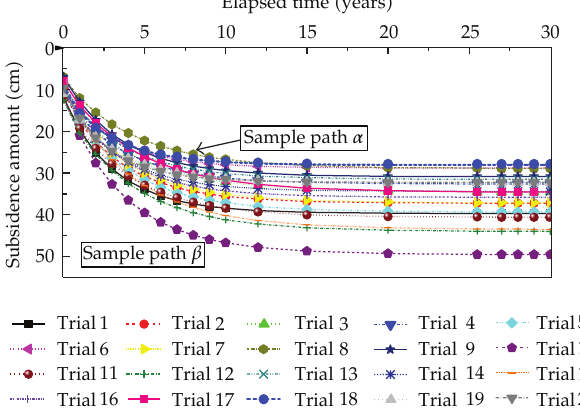
Figure 2: Examples of simulation results of inhomogeneous